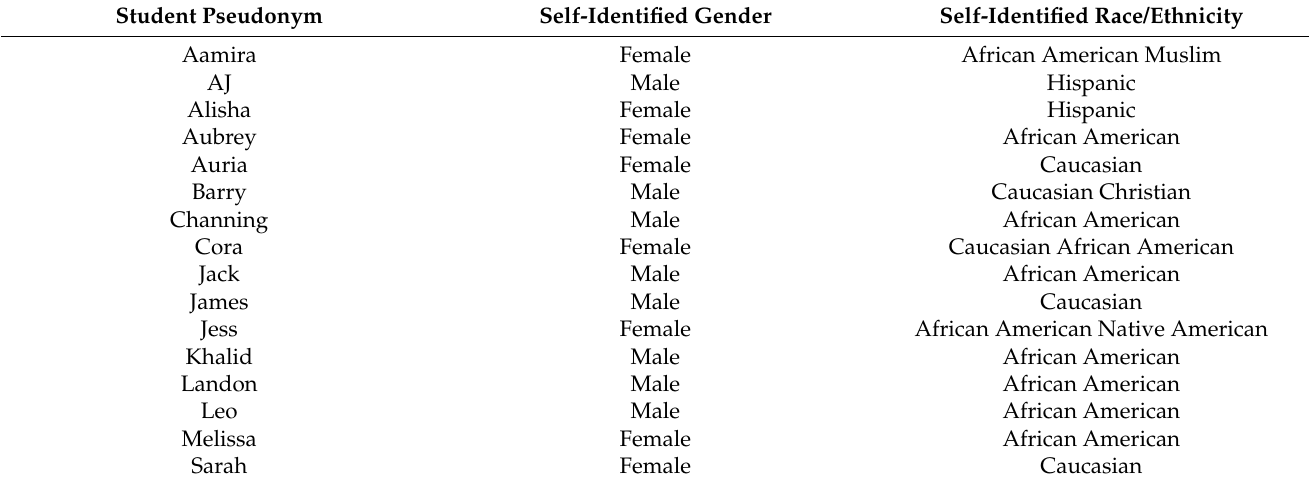
Table 2. Student Participant Details.